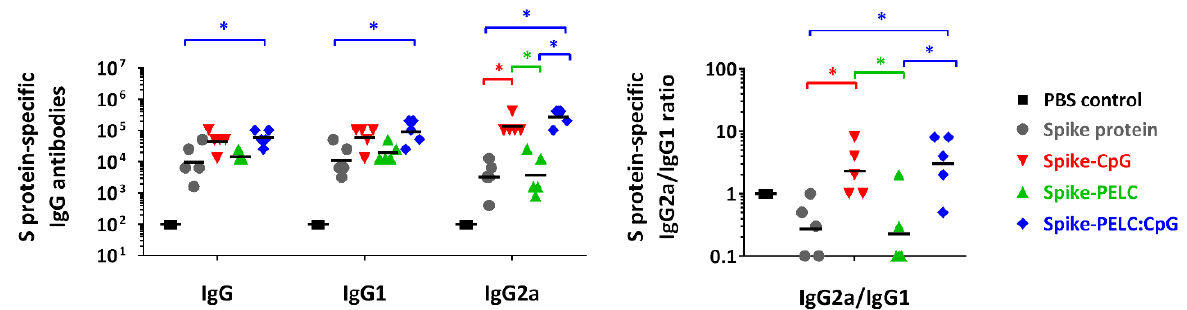
Figure 2. Antigen-specific antibody responses following three intranasal doses of PELC:CpG-formulated S protein in BALB/c mice. Mice ( n = 5) were intranasally (i.n.) administered full-length SARS-CoV-2 spike subunit protein either with CpG, PELC, or their combination. At week 2 and week 4, all mice were boosted i.n. with the same vaccine formulations. The total IgG and IgG subtype antibodies in serum samples at week 5 are expressed as the individual values with the GMT. The log-transformed values of antibody titers were compared by employing ANOVA model followed by Bonferroni’s multiple comparison test. * p <